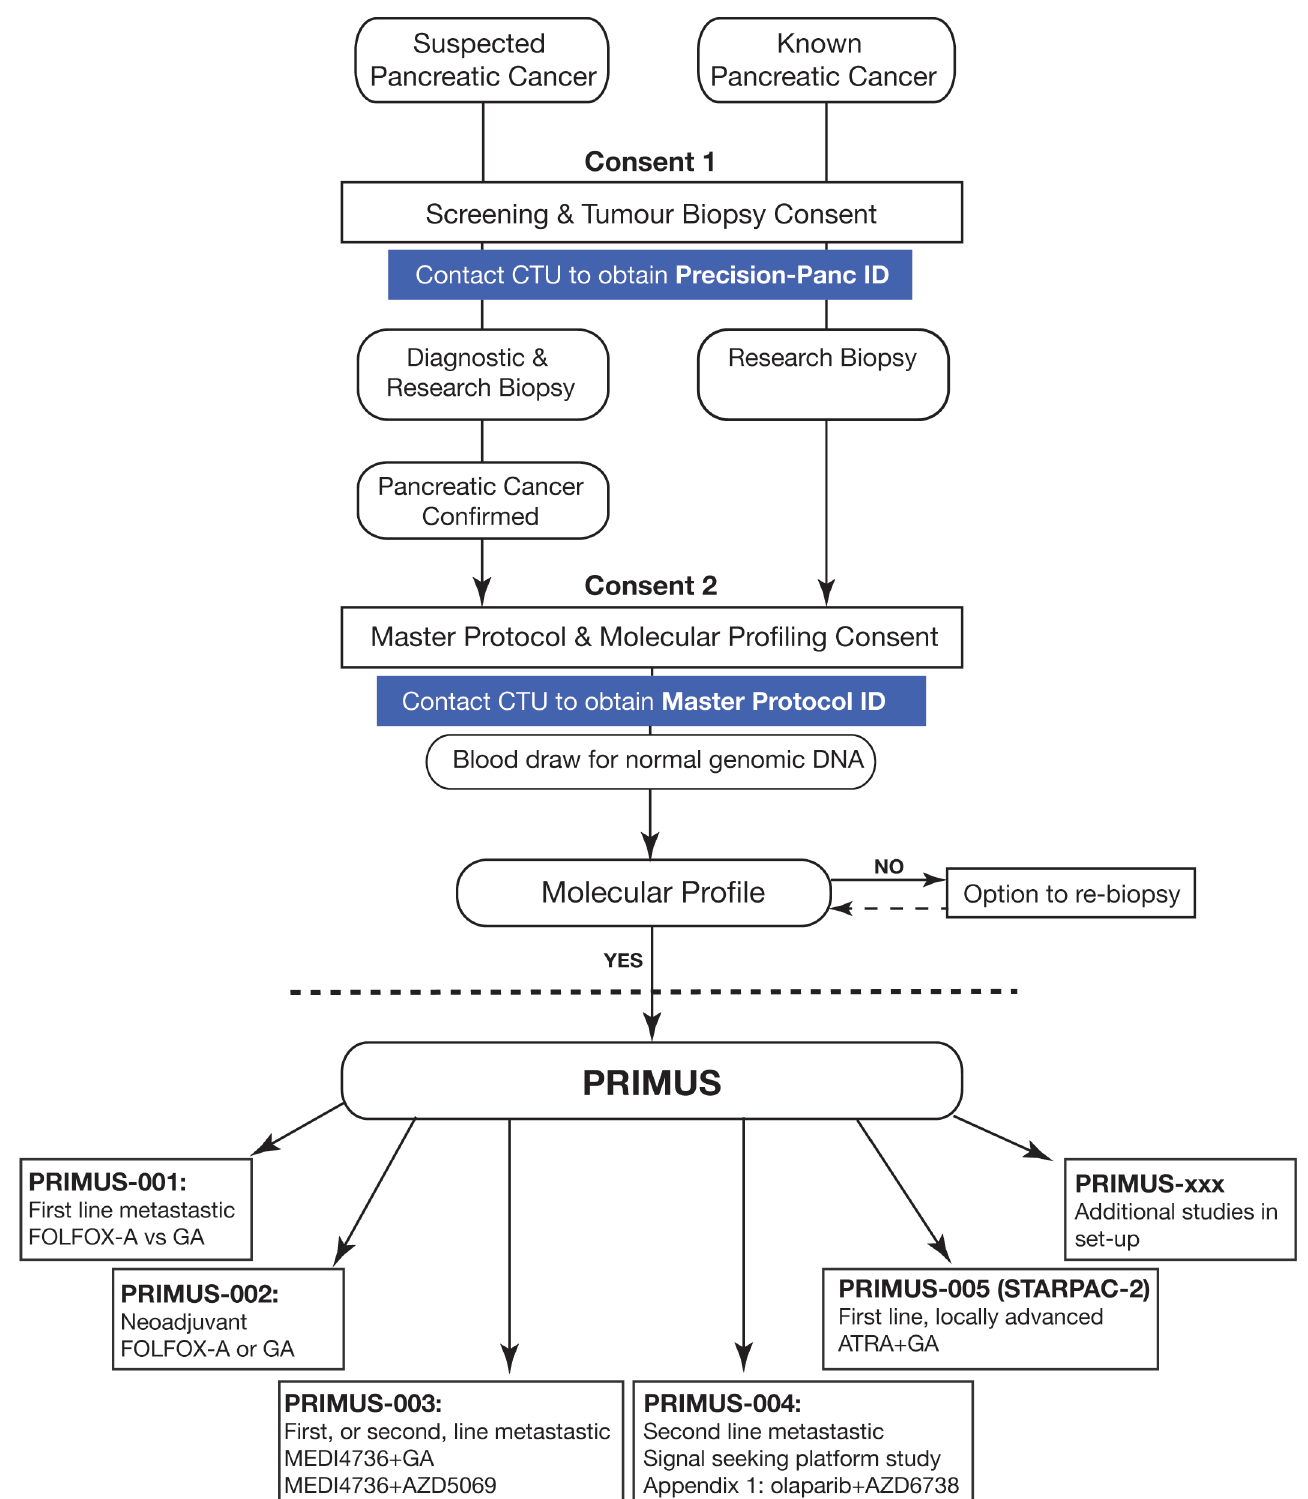
Figure 2. Precision-Panc Master Protocol and different Pancreatic canceR Individualised Multi-arm Umbrella Study (PRIMUS) studies. CTU (Clinical Trials Unit), FOLFOX-A (FOLFOX and nab-paclitaxel), GA (gemcitabine and nab- paclitaxel), ATRA (all-trans retinoic